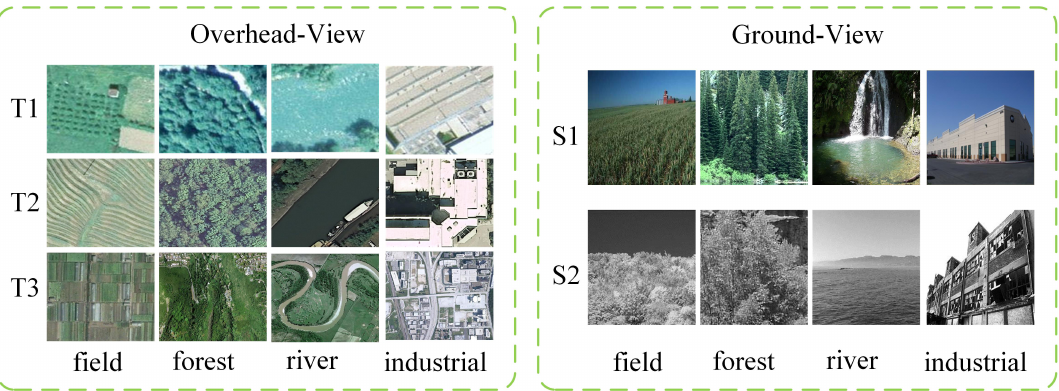
Figure 4. Samples of our cross-view datasets. Table 1. Statistical number of images in Cross-view scene dataset. SUN database (S1) and Scene-15 (S2) are the source domains, while Banja Luka (T1), UC Merced (T2), and WHU-RS19 (T3) datasets are the target domains.